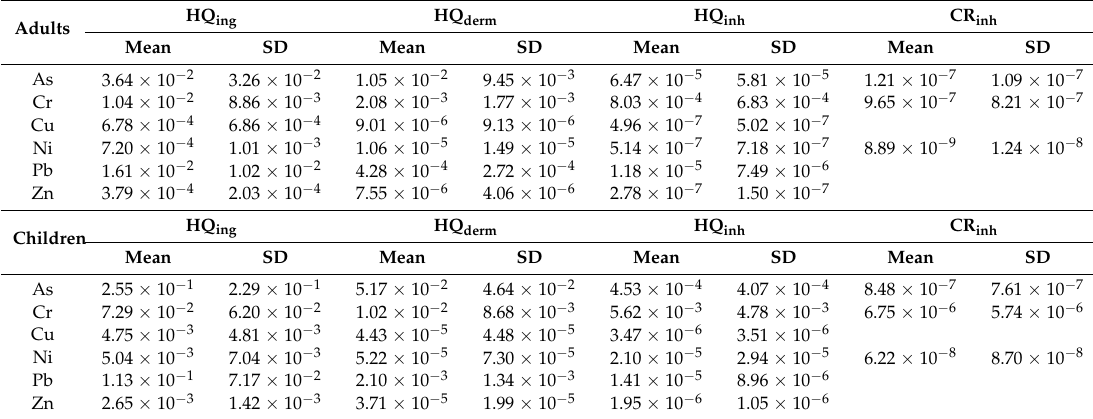
Table 2. Health risks from trace metals in Golden Triangle